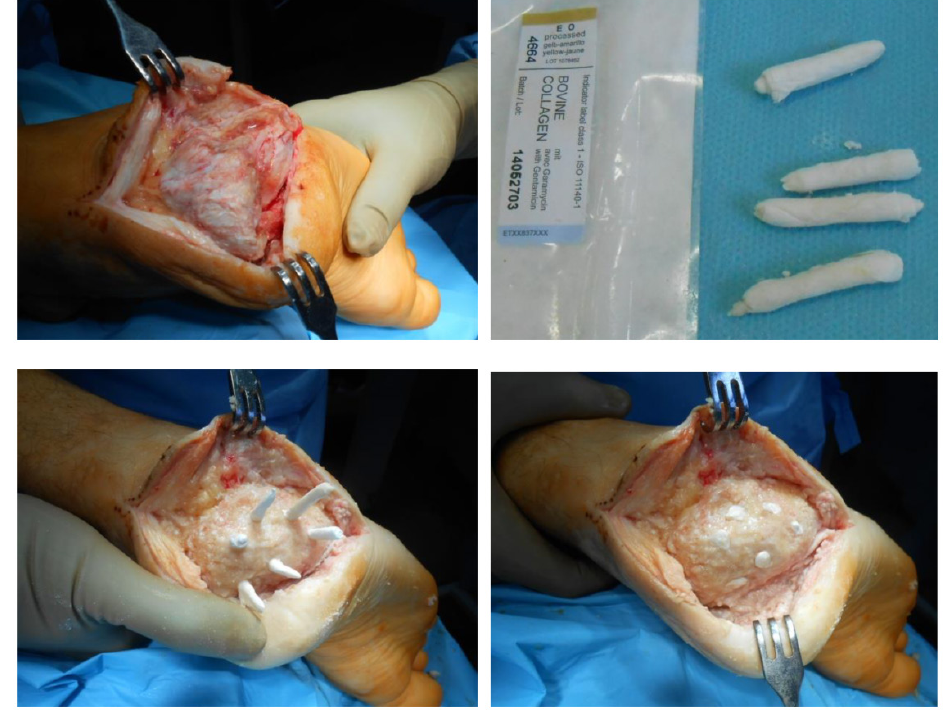
Figure 1 . a . Split heel approach to the calcaneus. b . Preparation of collagen-gentamicin sponge “pegs” c . Introduction of collagen-gentamicin sponge “pegs” into drill-holes. d . Appearance of calceneus after application of local antibiotic carrier into